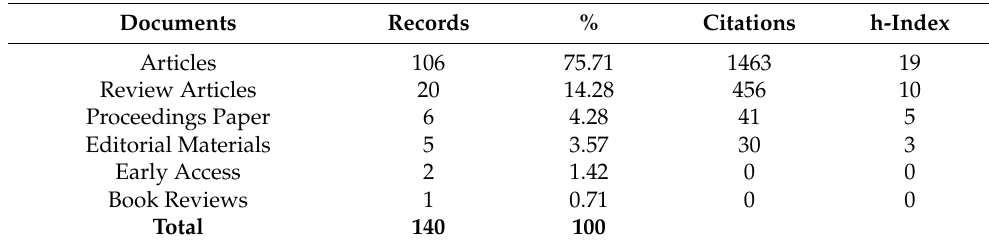
Table 3. Document types in health sciences